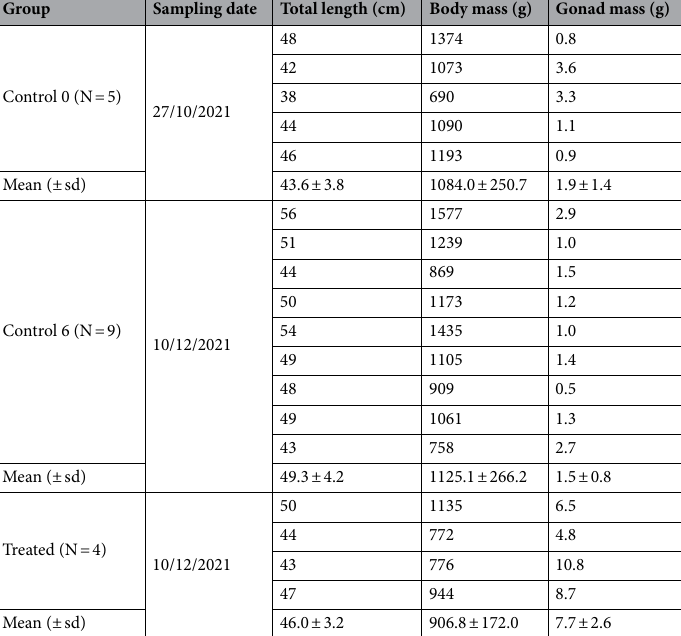
Table 1. Biometric data of control and rFsh-treated juvenile meagre males.